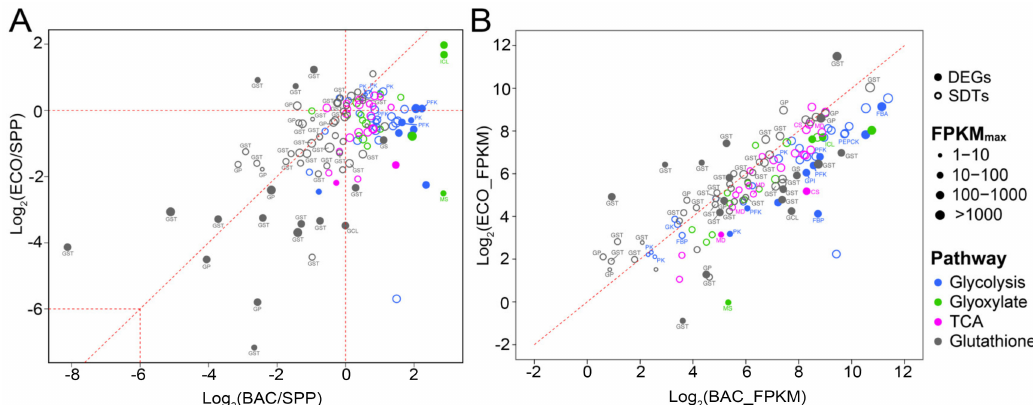
Figure 6. Relative expression levels of di ff erentially expressed genes (DEGs, solid circles; | log 2 (fold change) | ≥ 2) and significantly di ff erentiated transcripts with relatively lower fold changes (SDTs, open circles; 0 < | log 2 (fold change) | < 2) of T. thermophila involved in three carbon metabolism (glycolysis, TCA, and glyoxylate) and glutathione metabolism in the pairwise comparisons between two bacterial treatment (BAC and ECO) and SPP ( A ), and BAC vs. ECO ( B ). Each circle represents an individual gene, and its size indicates relative expression abundance. Abbreviations: GK, glucokinase; GPI, glucose-6-phosphate isomerase; PFK, 6-phosphofructokinase; FBP, fructose-1,6-bisphosphatase; FBA, fructose-bisphosphate aldolase; PK, pyruvate kinase; PEPCK, phosphoenolpyruvate carboxykinase; CS, citrate synthase; MD, malate dehydrogenase; ICL, isocitrate lyase; MS, malate synthase; GCL, glutamate-cysteine ligase; GS, glutathione synthase; GST, glutathione S-transferase; GP, glutathione